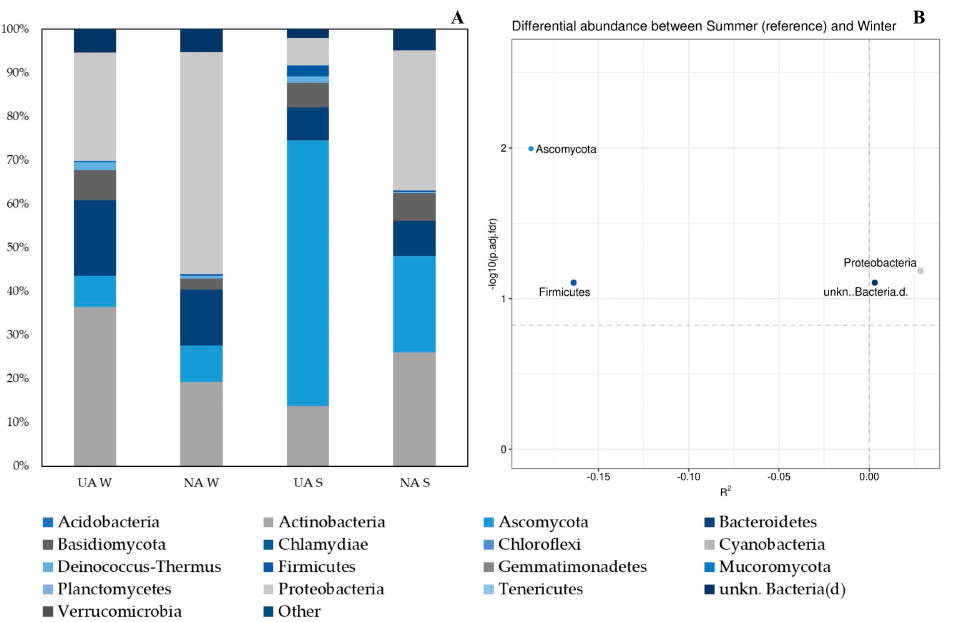
Figure 2. ( A ) Relative average abundance of phyllospheric bacterial and fungal taxa at Phylum level. ( B ) Differential Abundance Analysis (DAA) plot (based on ZicoSeq ( GUniFrac package). The plot shows the y -axis as the log10 (adjusted) p -value and the x -axis as the signed R 2 , which indicate the association direction with the covariate ( − and + with urban and natural areas, respectively). The names of differential taxa passing a specific significance cutoff (permutation-based FDR-adjusted p -Values = 0.1) are printed on the figure. ( A ) Only taxa with an average abundance ≥ 0.01% in at least one of the four groups (Urban Area W, Natural Area W, Urban Area S, Natural Area S) of samples are shown. Samples are grouped according to sampling season (W = winter or S = summer) and environmental features (Urban Area or Natural Area).